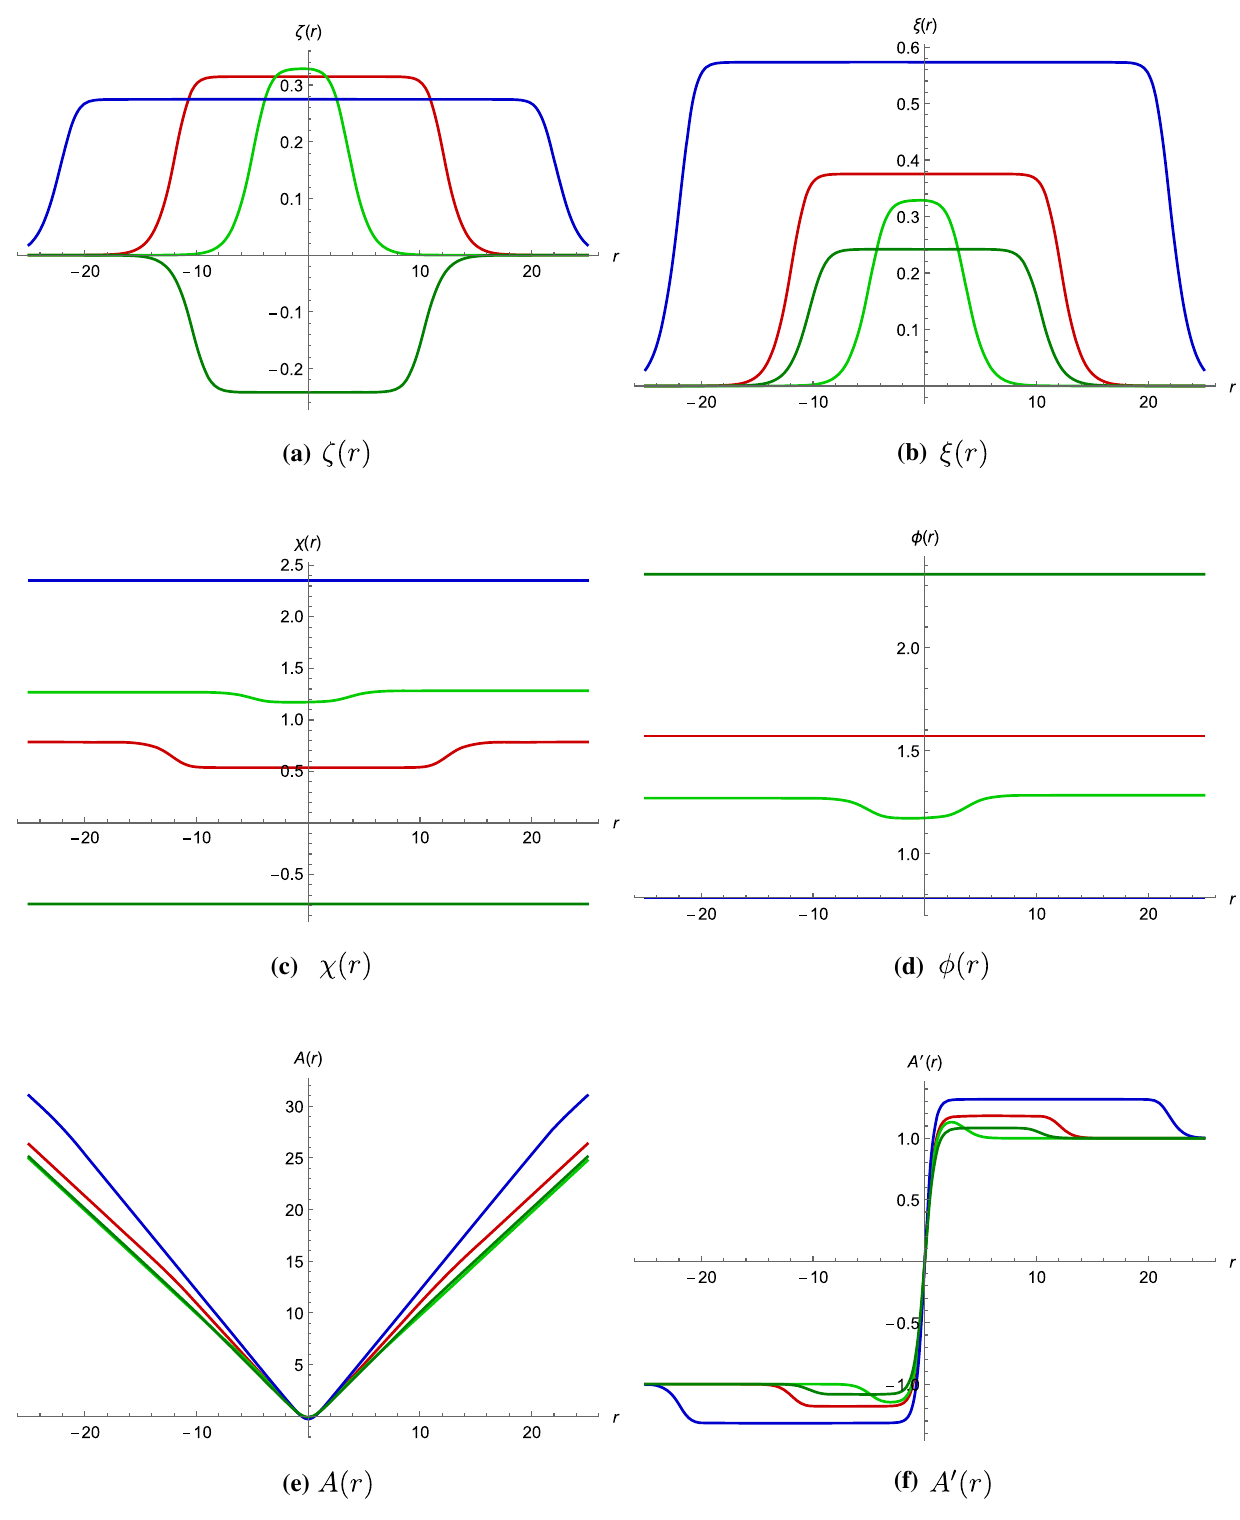
Fig. 15 Profiles of scalar fields (ζ,ξ,χ,φ) and of the warped factor A for SO ( 8 )/ SO ( 8 ) Janus solutions that flow to U ( 3 ) , G 2 , G 2 and SU ( 3 ) critical points with ω = π as functions of the radial coordinate 8